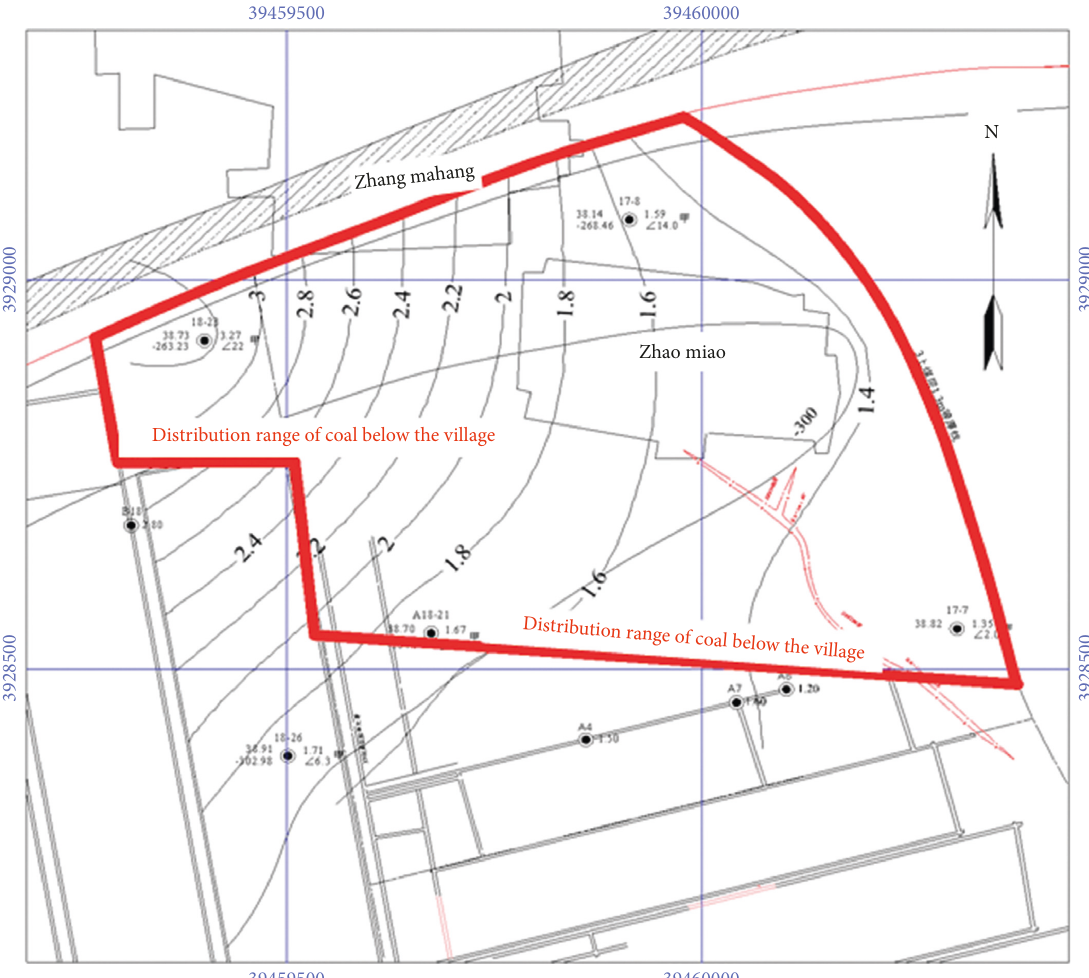
Figure 1: Similar simulated geological prototype area (Red line in the